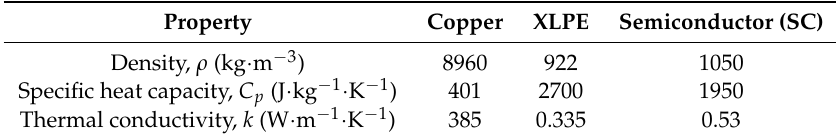
Table 4. Cable thermal and mechanical properties